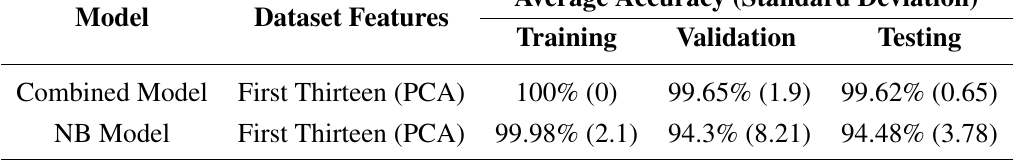
Table 4. Third model using Dataset-3 (13-d) performance profile along with a comparison to Naive Bayes